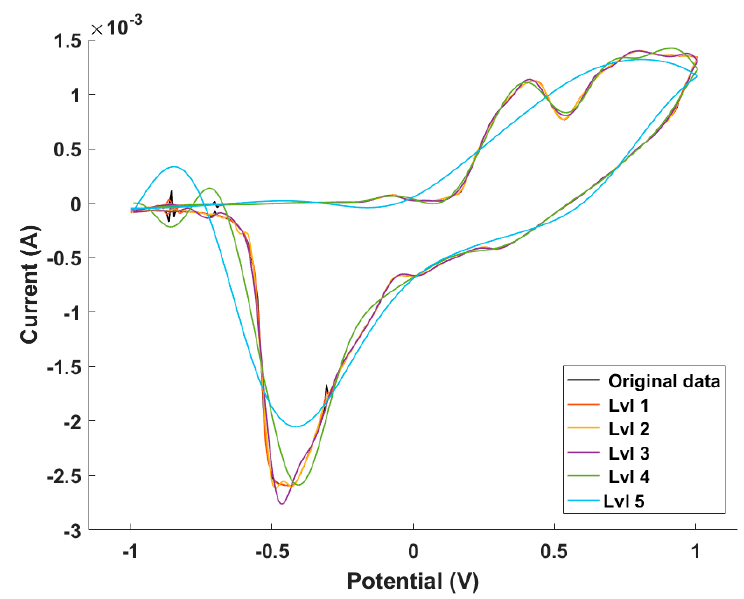
Figure 4. Reconstruction of the first 5 compression levels versus the original signal for cyclic voltammogram measured with the Ag electrode.